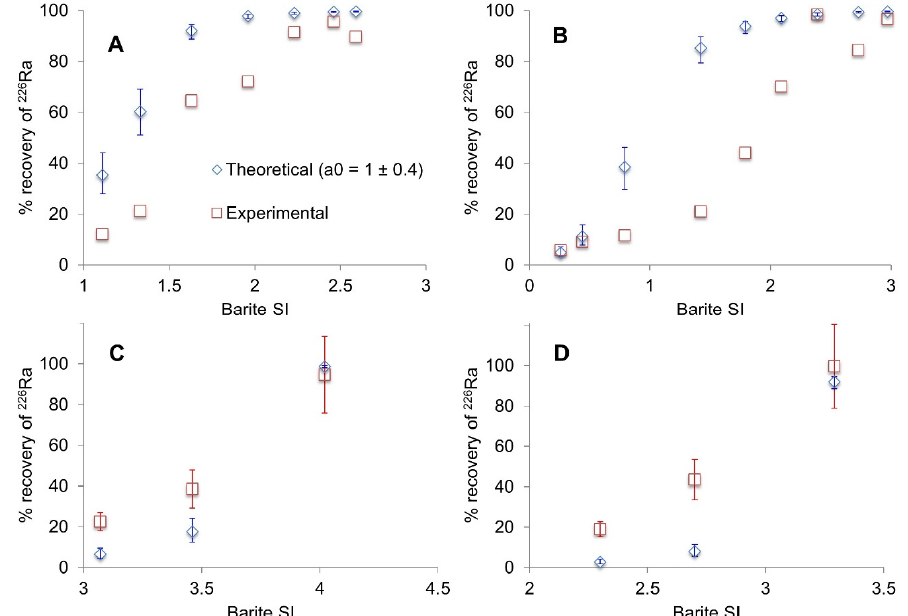
Figure 4. Theoretical vs. experimentally determined % 226 Ra recovery. ( A ) 0.3 M NaCl with 0.22 mM Ba 2+ and varying SO 42 − ; ( B ) 3 M NaCl with 0.22 mM Ba 2+ and varying SO 42 − ; ( C ) 0.3 M NaCl with 5 mM Ba 2 + and varying SO 42 − ; ( D ) 3 M NaCl with 5 mM Ba 2+ and varying SO 42 − . 2 σ error based on counting statistics only. SI—Saturation Index. Theoretical values are based on a 0 = 1 ± 0.4.